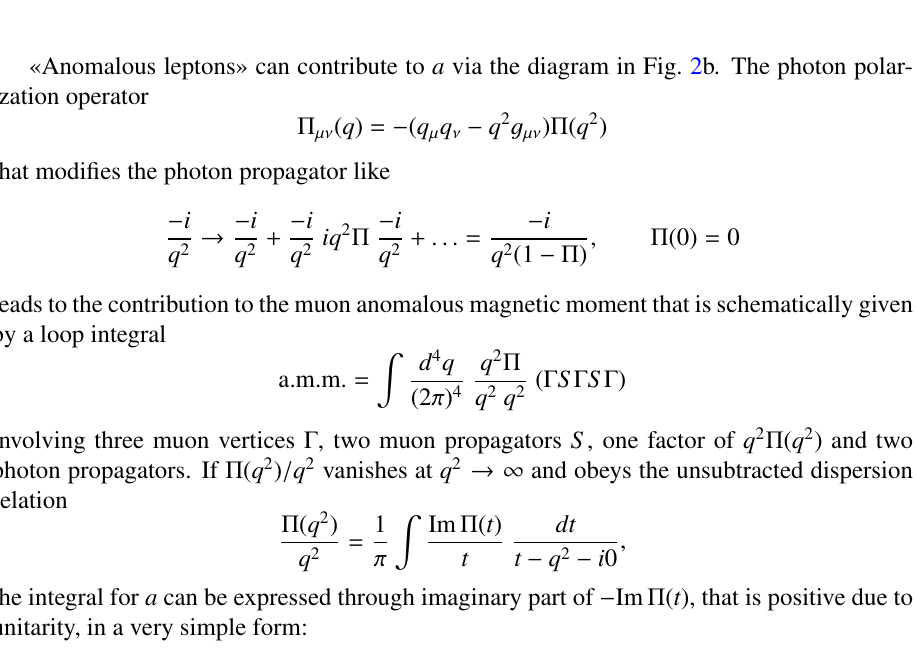
Figure 2. Contributions to the muon anomalous magnetic moment a : a) Leading order, b) hadron vacuum polarization. «Anomalous leptons» can contribute through the diagram b)